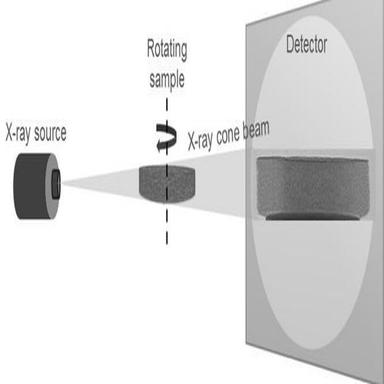
A lab-based micro-CT setup with the X-ray tube focal spot, producing conical X-rays, a sample mounting on a rotation stage and the X-ray detector.